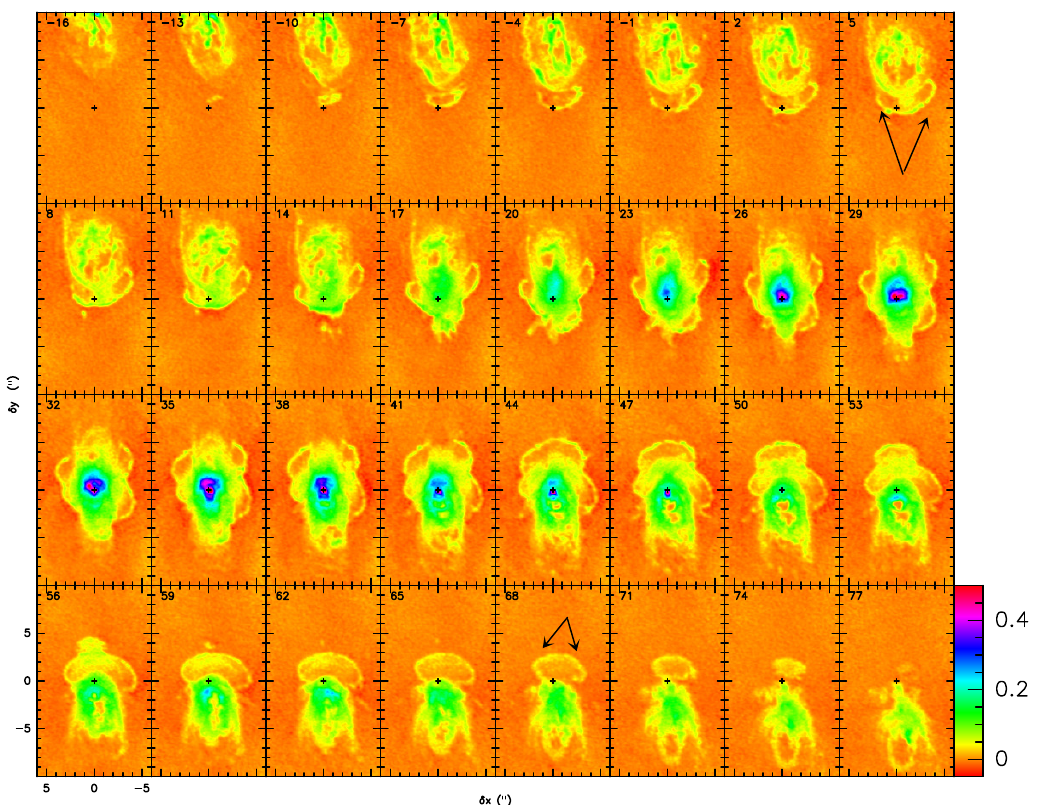
Figure 5. Velocity-channel maps of 12 CO(3 − 2) in the velocity range where two faint, elongated bubble-like features (dubbed the fish-bowls ) are discovered in the central regions of